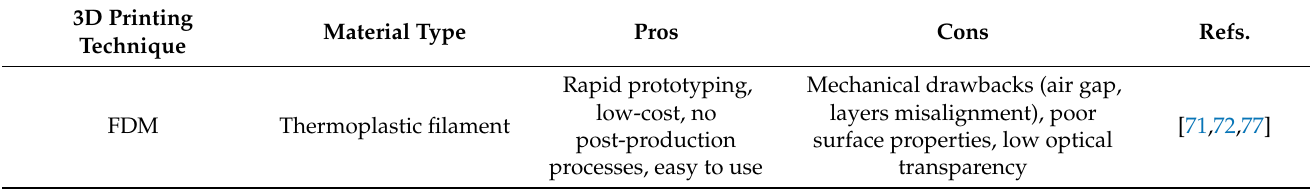
Table 3. Short overview about main 3DP techniques advantages and